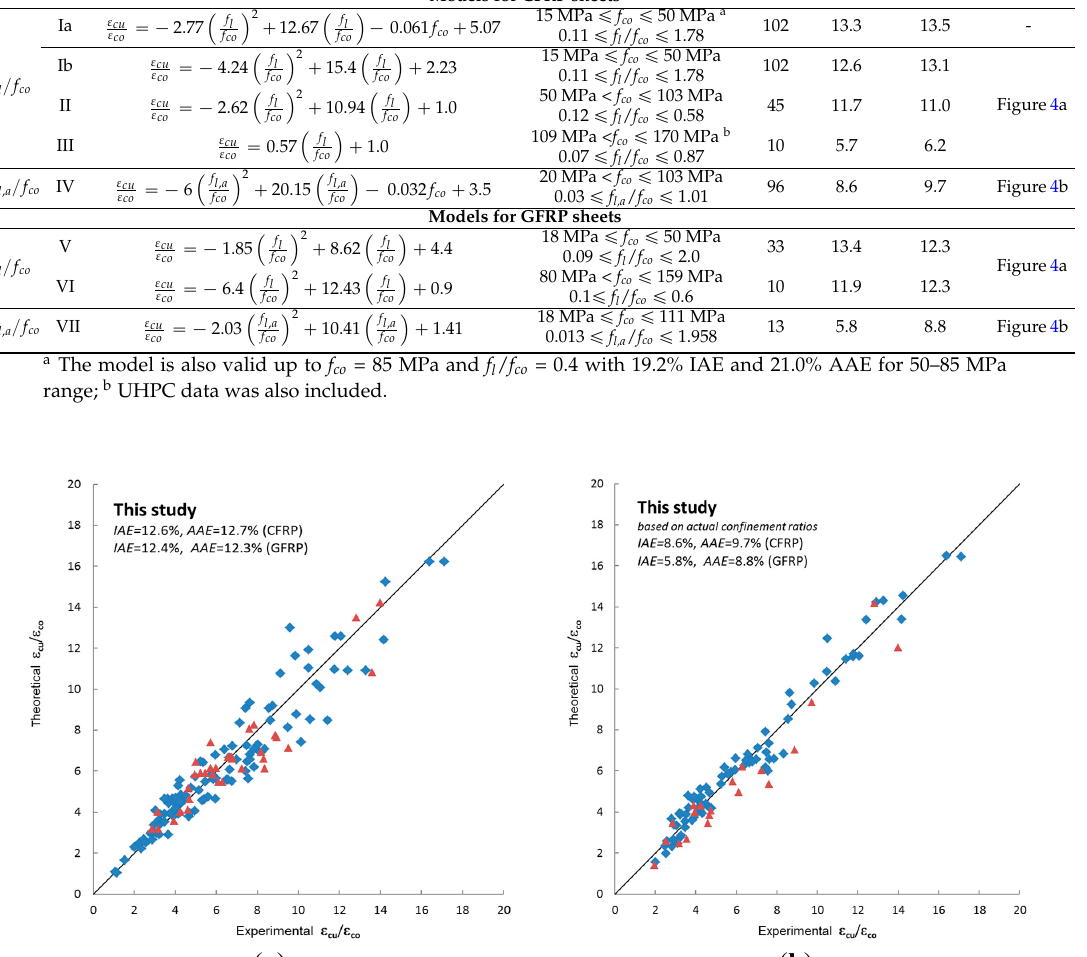
Figure4aII ε cu